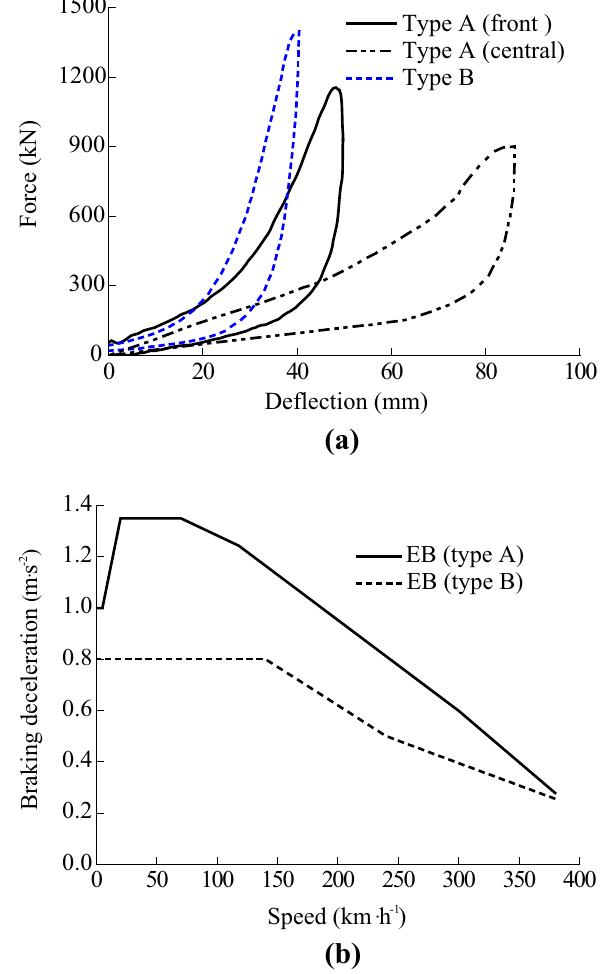
Fig. 8 Characteristic curves. a Force–deflection relations of draft gear. b EB braking